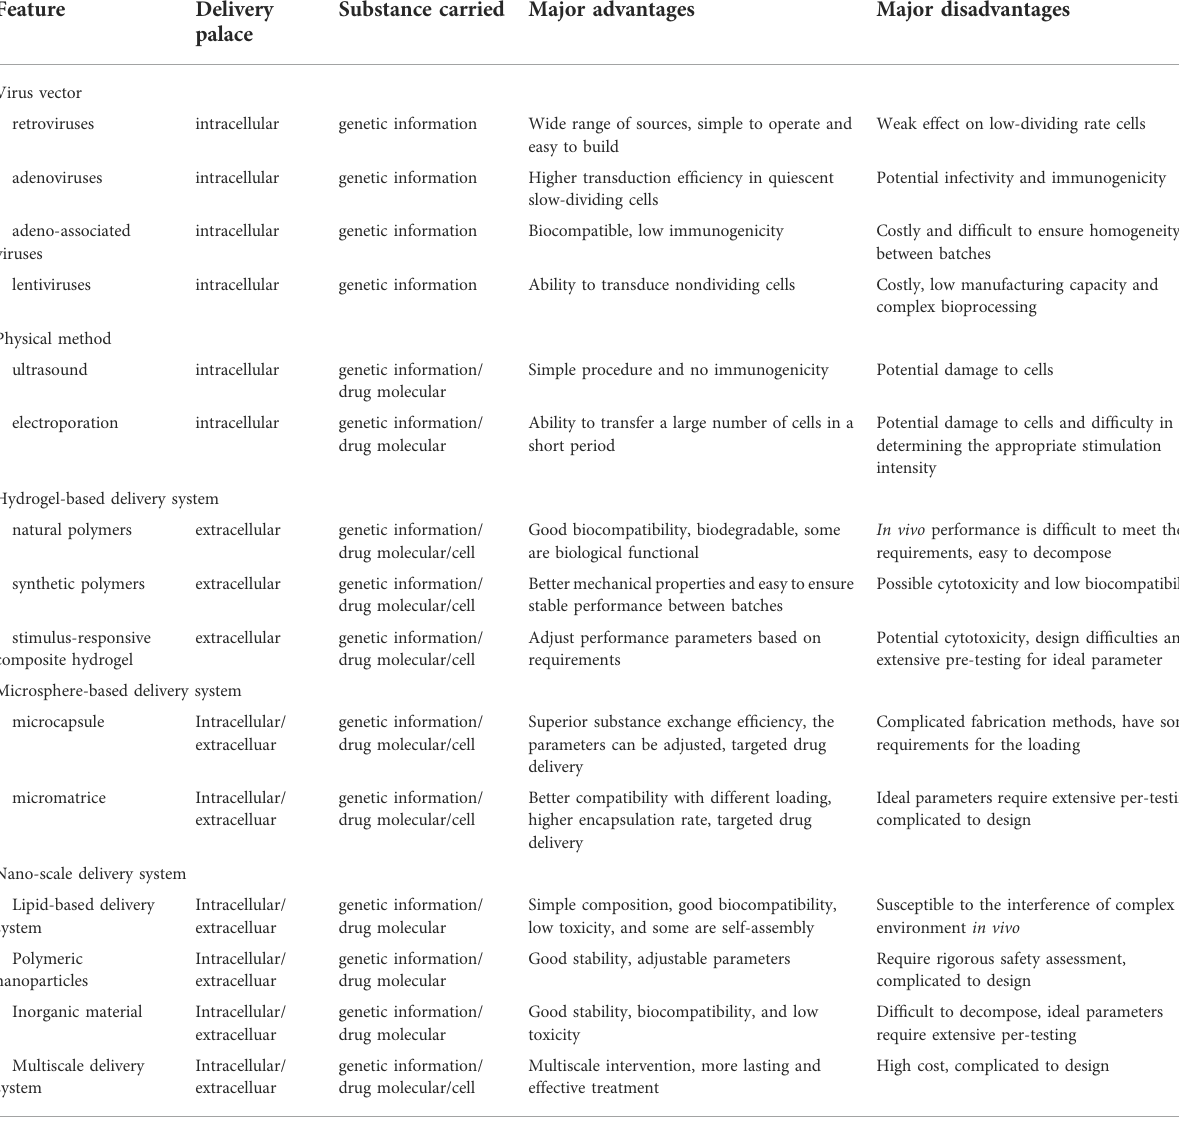
TABLE 1 A brief comparison of various delivery